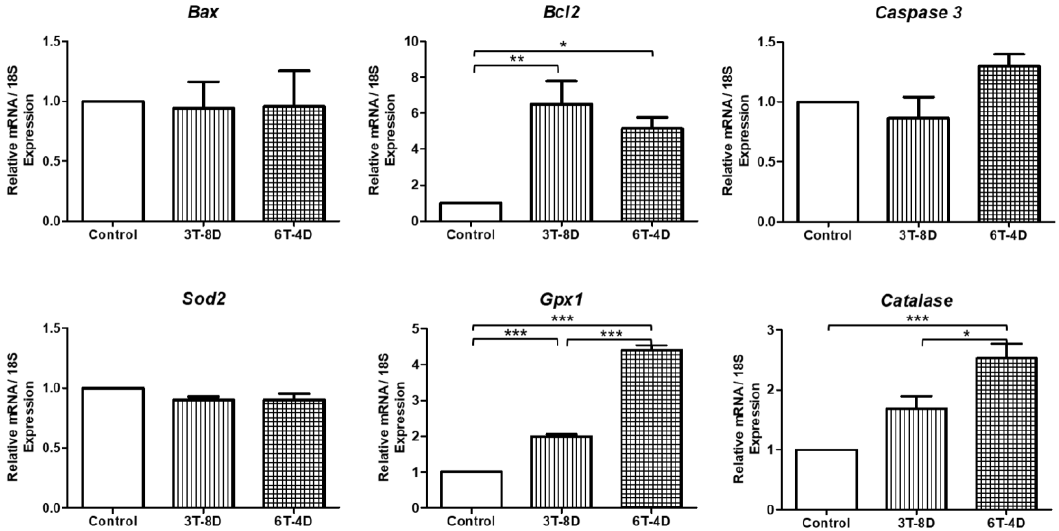
Figure 6. Relative expression to 18S of apoptosis and oxidative stress-related genes from the ovary of the control and groups of human adipose-derived stem cell conditioned medium (ASC-CM) intravenous injection to 6-month-old ICR mice. Data are expressed as the mean ± standard error of the mean (SEM). * p < 0.05, ** p < 0.01, *** p < 0.001. 4D-6T, six times injection in 4 four day intervals; 8D-3T, three times injection in eight day intervals.